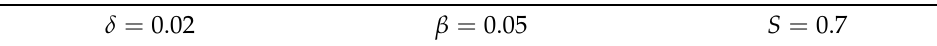
Table 1. Set of parameters of the model (1). δ = 0.02